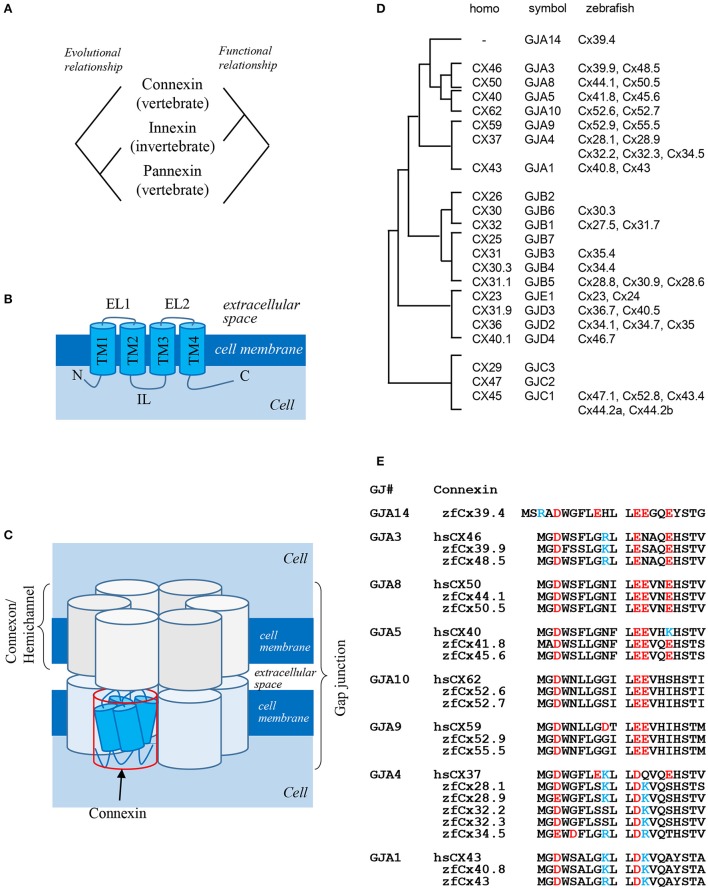
Gap junction proteins. (A) Relationship among three types of gap junction proteins: connexins, innexins, and pannexins (Baranova et al., 2004). (B) Structure of connexin proteins. N: N-terminus; TM: transmembrane domain; EL: extracellular loop; IL: intracellular loop; C: C-terminus (Kumar and Gilula, 1996). (C) Schematic presentation of a gap junction (Kumar and Gilula, 1996). (D) Phylogenic relationship between human and zebrafish connexins (Eastman et al., 2006; Cruciani and Mikalsen, 2007). (E) Sequence alignment of N-terminal domains of human and zebrafish alpha-type connexins (Connexin sequences were obtained from genome data base in Sanger Institute, http://www.sanger.ac.uk/).